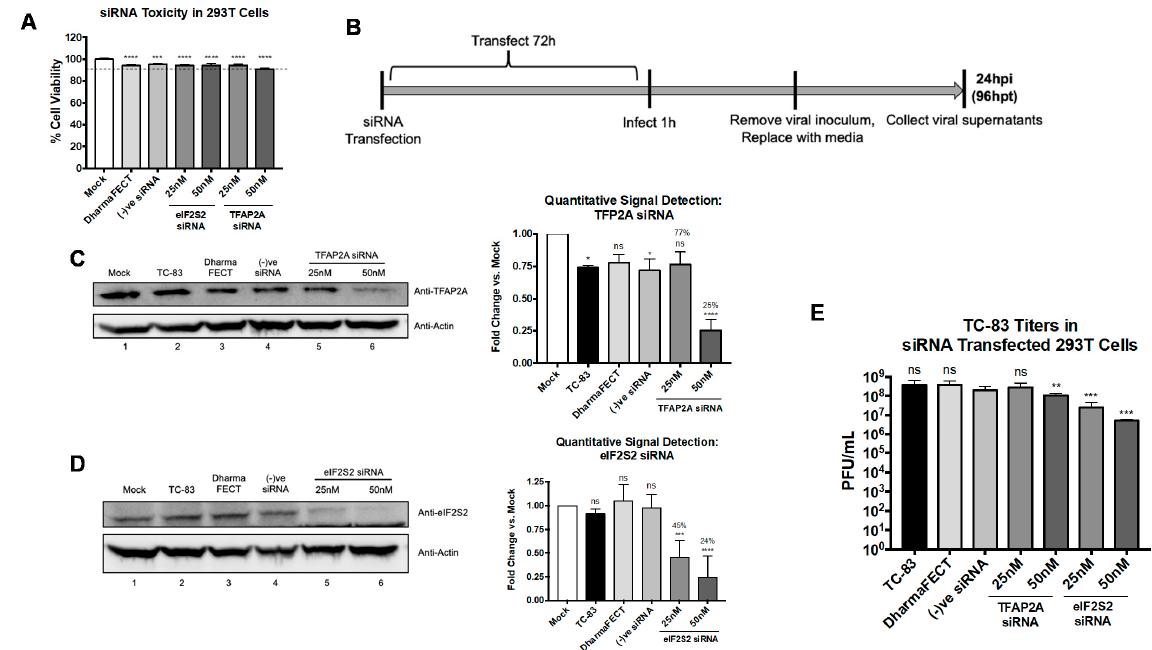
Figure 8. EIF2S2 supports a pro-viral role for VEEV TC-83 replication and VEEV nsP3 colocalizes with TFAP2A. ( A ) 293T cells were transfected with 25 or 50 nM siRNA targeting TFAP2A or eIF2S2, with an off-target negative control siRNA, DharmaFECT only treatment, or mock-transfection treatment and incubated for 72 h. Cell viability was measured, as described in Materials and Methods and calculated versus mock-transfected control. Dotted line represents the 90% cut-off point. ( B ) SiRNA knockdown and infection scheme. Then, 293T cells were transfected with 25 or 50 nM siRNA targeting TFAP2A or eIF2S2 and incubated for 72 h. Cells were infected with TC-83 for 1 h at MOI 0.1 and at 24 hpi, viral supernatants and cellular lysates were obtained, as described in Materials and Methods. Graph is representative of two independent experiments performed in triplicate ( n = 6). Cellular lysates to confirm host protein knockdown were probed using Western blot for TFAP2A ( C ) or eIF2S2 ( D ) as described in Materials and Methods. Signal was quantified and normalized to actin loading control, calculated as fold-change vs. mock-transfected control group. Western blot and graphical data are representative of two independent experiments ( n = 2). ( E ) Viral supernatants of siRNA transfected cells were evaluated by plaque assay, as described in Materials and Methods. Graph is representative of two independent experiments performed in triplicate ( n = 6). Images are representative of two independent experiments. * p < 0.0332, ** p < 0.0021, *** p < 0.0002, **** p < 0.0001, and ns, not significant.